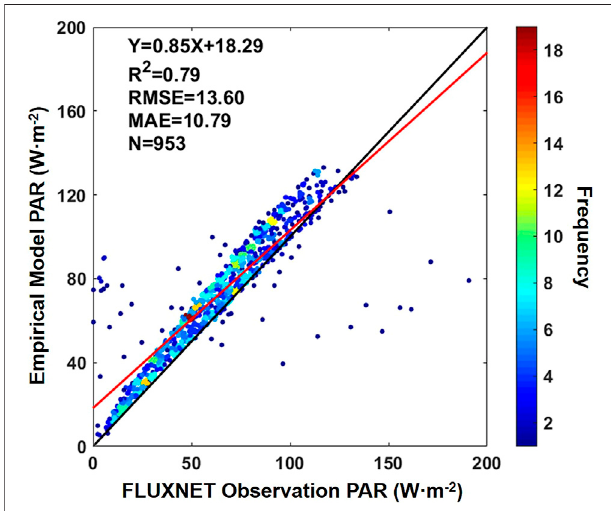
FIGURE 4 | Density scatterplots of the model-simulated PAR. The solid black and solid red lines indicate the 1:1 line and the line regression line,